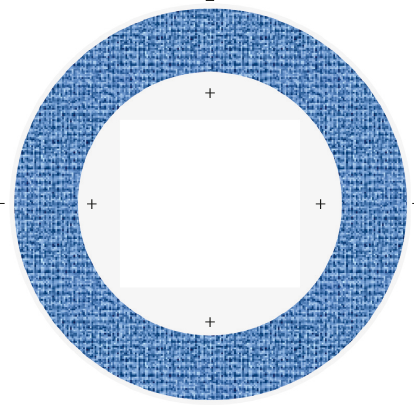
Figure 1: Schematic of the core-shell microsphere, which has a core-shell double-layered structure.